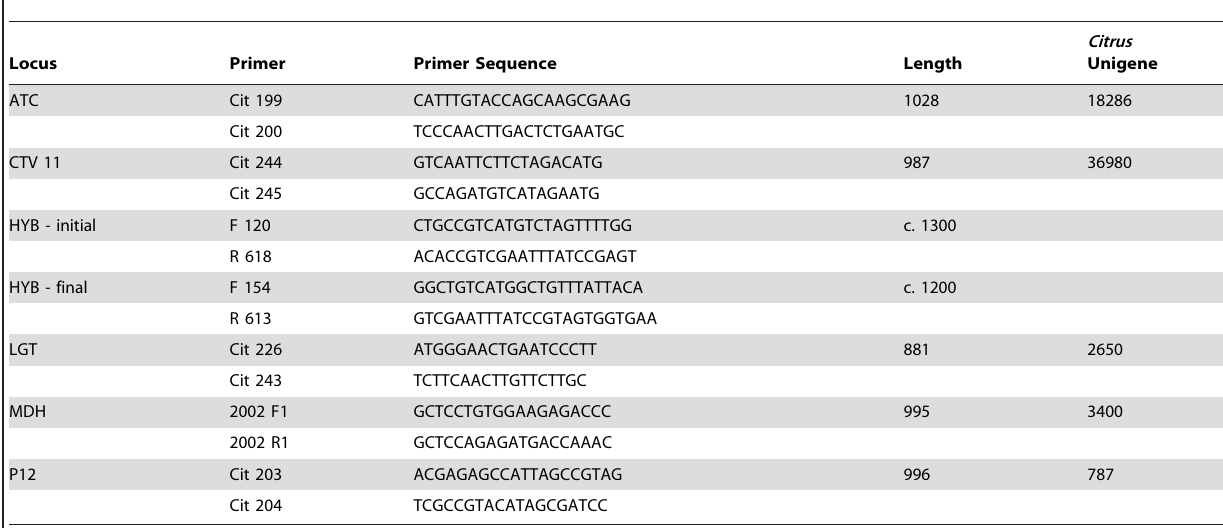
Table 2. Primers used to amplify gene fragments targeted for sequence